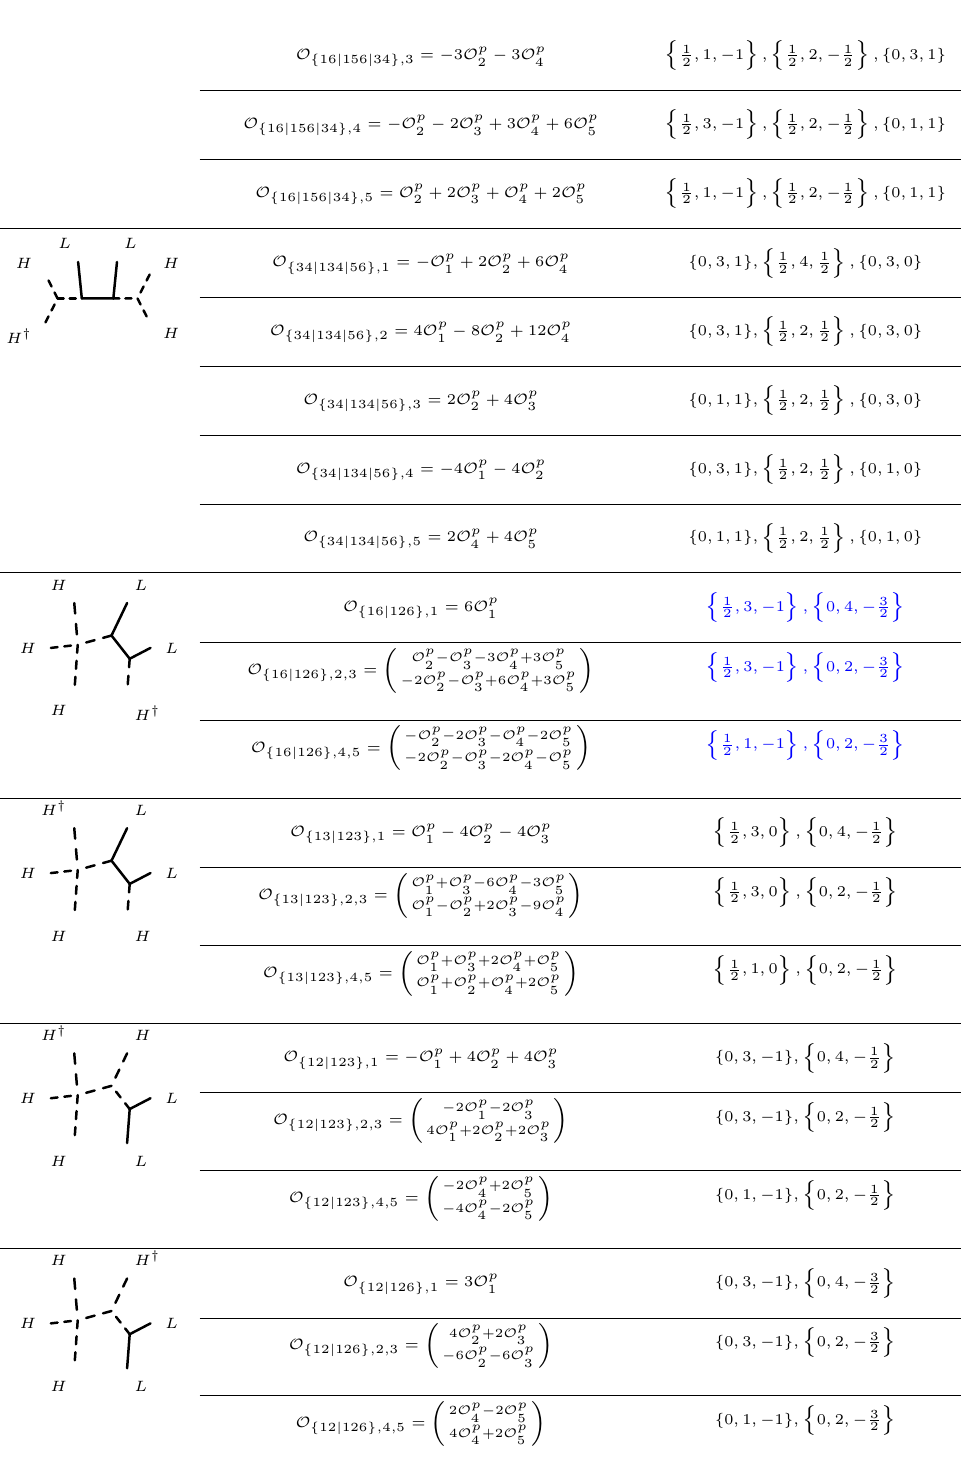
Table 13. The complete j-basis for the operator L 2 H 3 H † , which corresponds to the complete UV resonances generating the neutrino masses from the dimension 7 operators at the tree-level. If the j-basis does not contain O p , the UV resonance should vanish because of the repeated field in the 1 operator